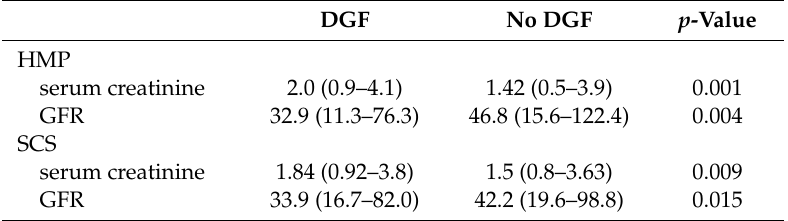
Figure 5. ( A ) Median serum creatinine and ( B ) estimated glomerular filtration rate (MDRD) after a median follow-up of 24 months for patients with immediate and delayed graft function. ° statistical outliers. Table 5. Subgroup analysis of serum creatinine and eGFR in patients with immediate graft function and DGF.